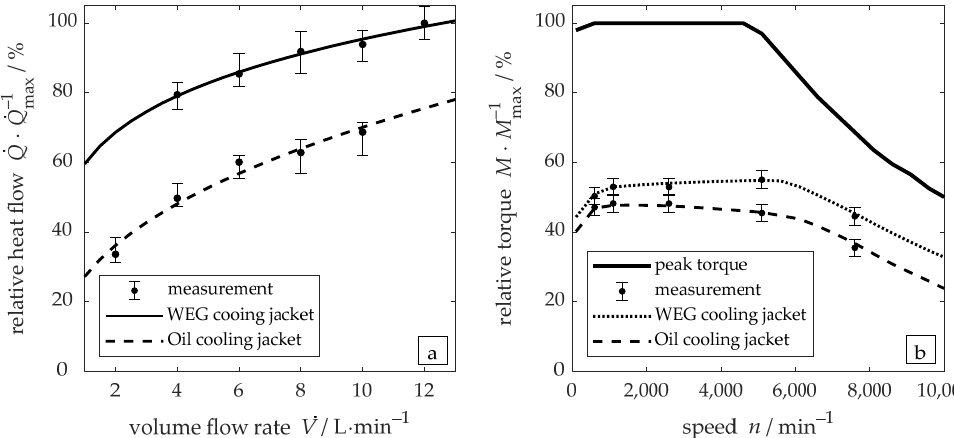
Figure 6. Validation of the thermal model with test bench data: ( a ) comparison of simulated heat flows for different volume flow rates for the WEG and oil-cooling jacket with results of the cooling jacket test bench and ( b ) comparison of simulated continuous torques for the water-cooling jacket and the rotor cooling jacket with results of the electric machine test bench.